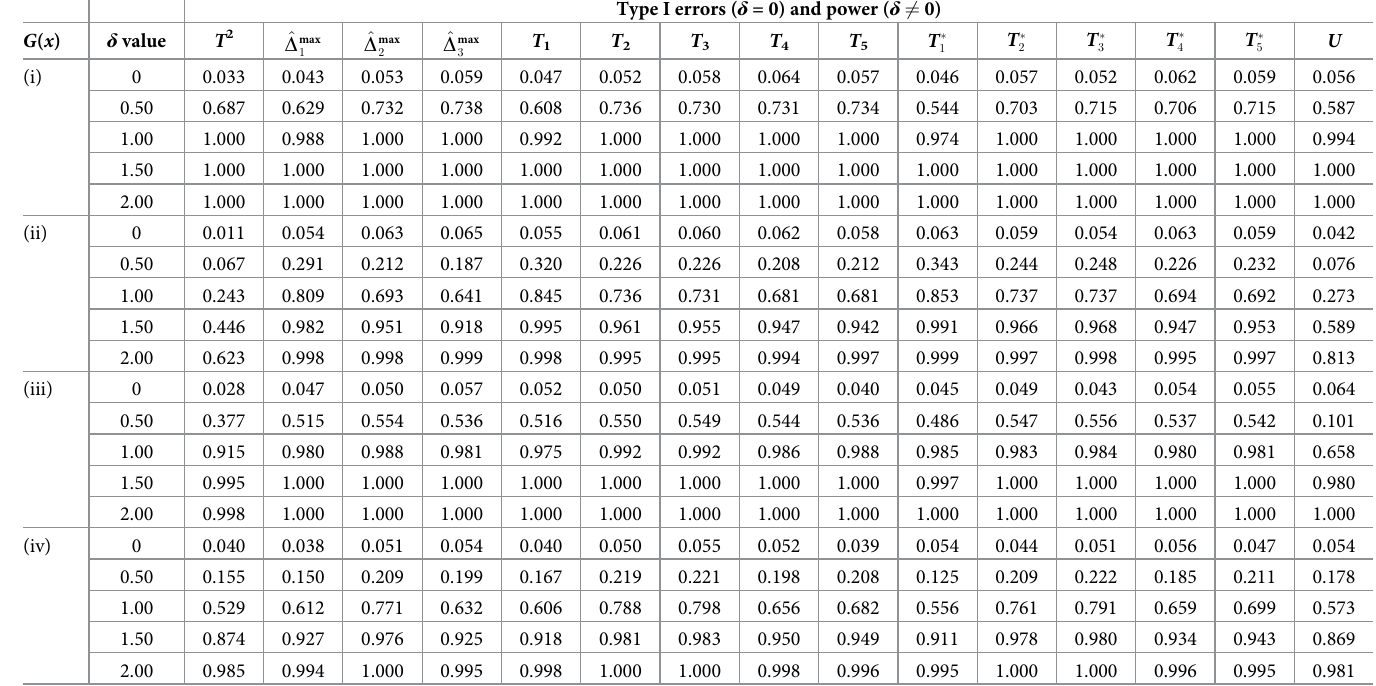
Table 5. Type I errors ( δ = 0) and power ( δ 6¼ 0) given by the investigated test statistics based on permutation approach in detecting location shift between two sam- ples generated from the four pairs of F ( x )and G ( x )with the non-independent variance-covariance matrix and sample sizes n = m =